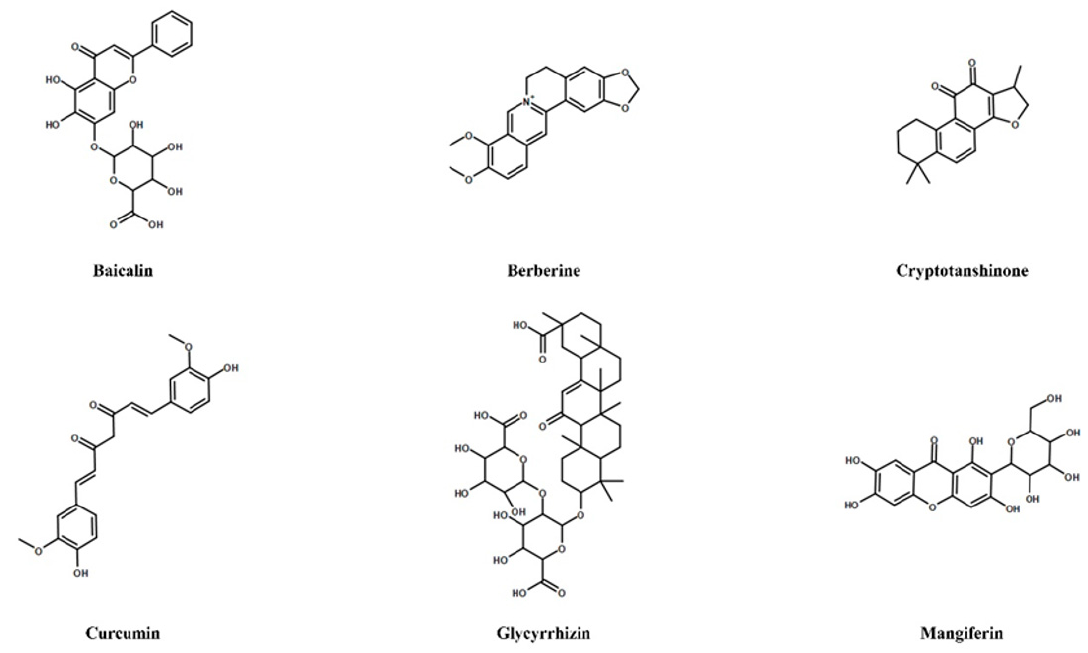
Figure 3. Chemical structures of most significant secondary metabolites targeting both COX-2/mPGES-1 pathway and Th17/Treg axis.